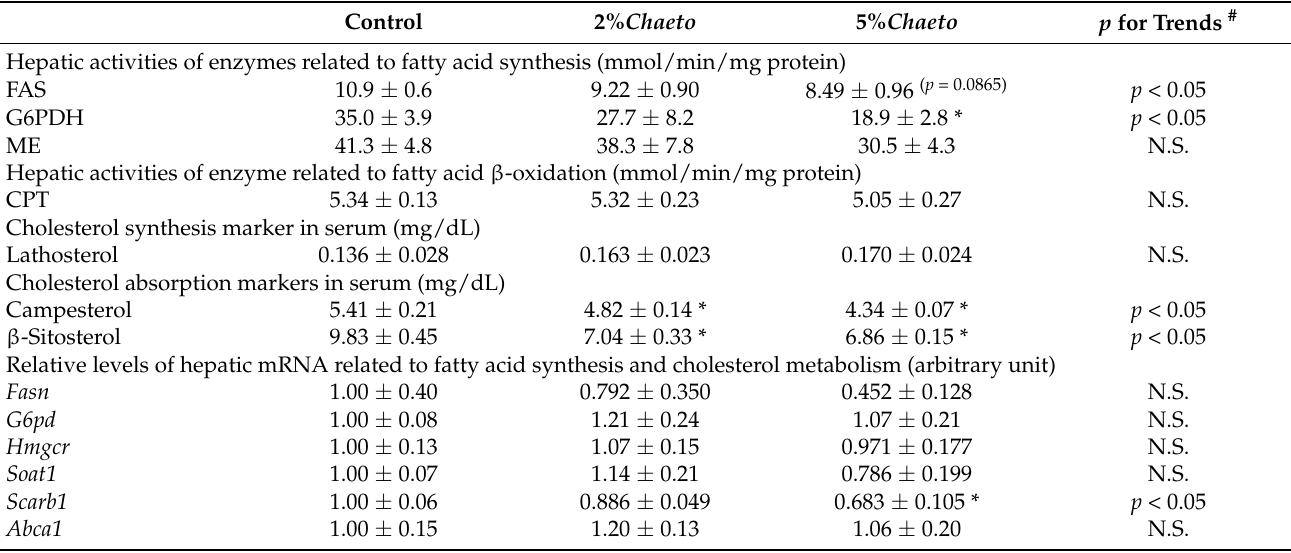
Table 5. Effects of C. gracilis feeding on activities of hepatic enzymes related to fatty acid metabolism, serum levels of steroids, and relative levels of hepatic mRNA related to cholesterol metabolism in SD rats. Control 2% Chaeto 5% Chaeto p for Trends